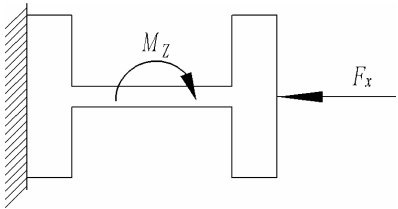
Figure 1. Force diagram of the flexible